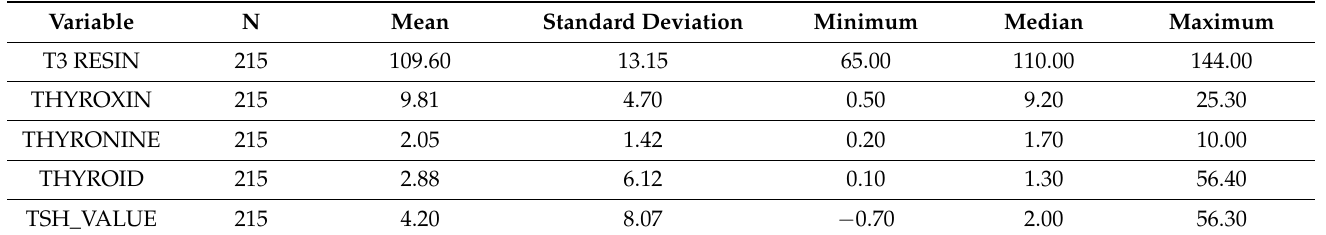
Table 1. Predictors for the thyroid